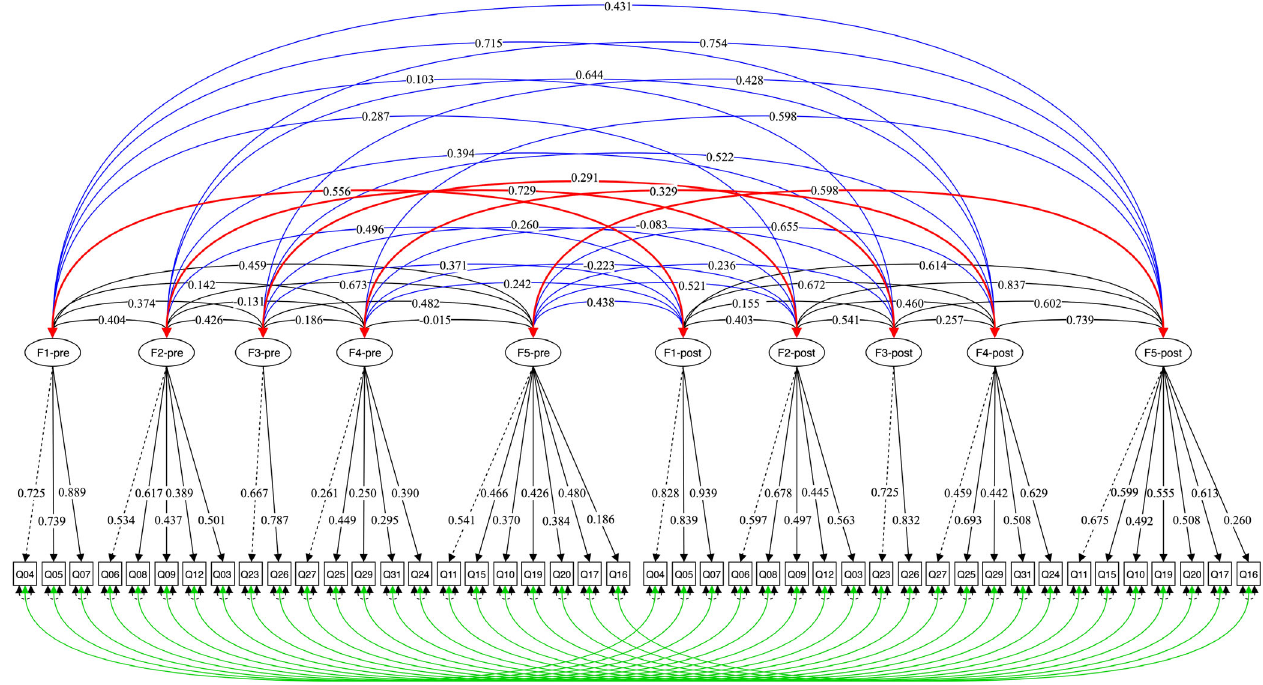
FIG. 3. Strict LMI model of the reduced CSEM. The modified Eaton5 model suggested the following five factors: F 1 ¼ Nettons ’ s 3rd ⃗ F ¼ q ⃗ E þ Superpos, F 3 ¼ ⃗ B by I , F 4 ¼ Electromagnetic interaction, and F 5 ¼ q in fields. Because of the data ’ s law, F 2 ¼ E longitudinal structure, the latent factors are allowed to correlate across time (the correlation between identical latent factors in the different time was in red curves; the correlation between different latent factors in the different time was in blue curves), and identical items over the two test occasions were allowed to covary. All parameters are